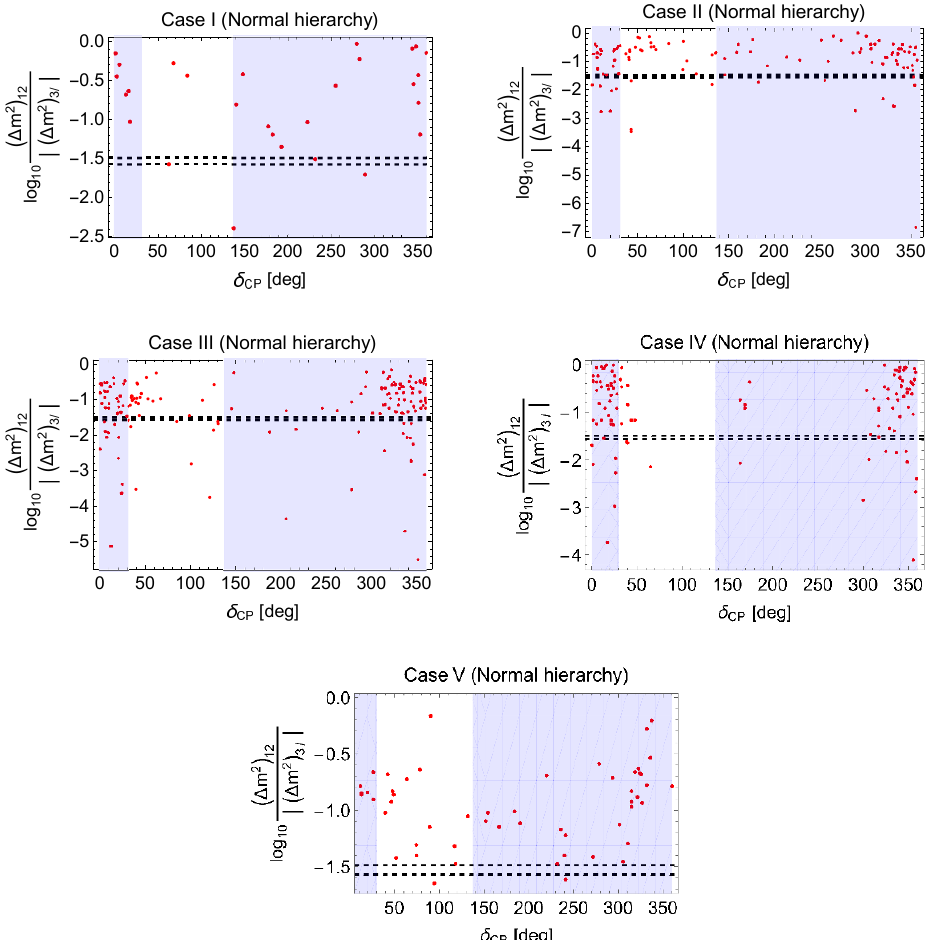
Figure 3 . log 10 (∆ m 2 21 / ∆ m 2 3 ℓ )– δ CP distributions among the parameter points where the three | | mixing angles are within the 3 σ regions. The pale blue regions show the 3 σ -favored region of δ CP in a recent global fit [52]. It is noted that no region of δ CP is 3 σ -disfavored in the results of the recent global fits [51, 53]. In each plot, the region between the two horizontal dashed black lines are 3 σ -favored for log 10 (∆ m 2 21 / ∆ m 2 3 ℓ ) | |